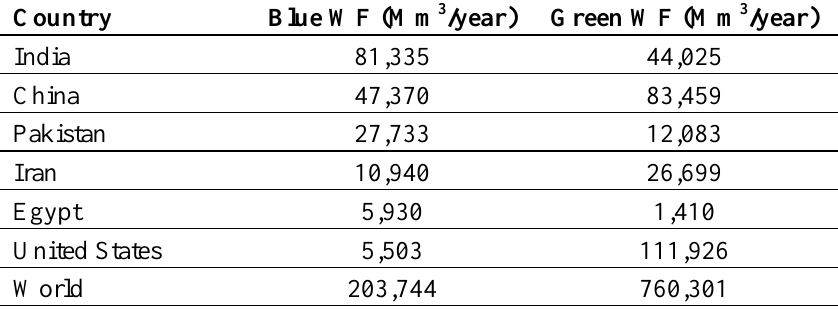
Table 2. Blue and green water footprint of wheat in India, China, Pakistan, Iran, Egypt, United States and total in the world obtained for the period 1996–2005 (from Mekonnen and Hoekstra